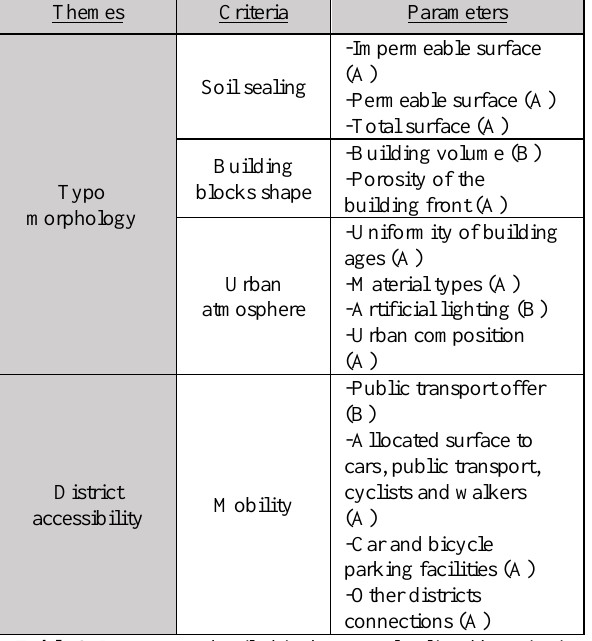
Table 2 . Parameters detailed in these results, listed by criterion.